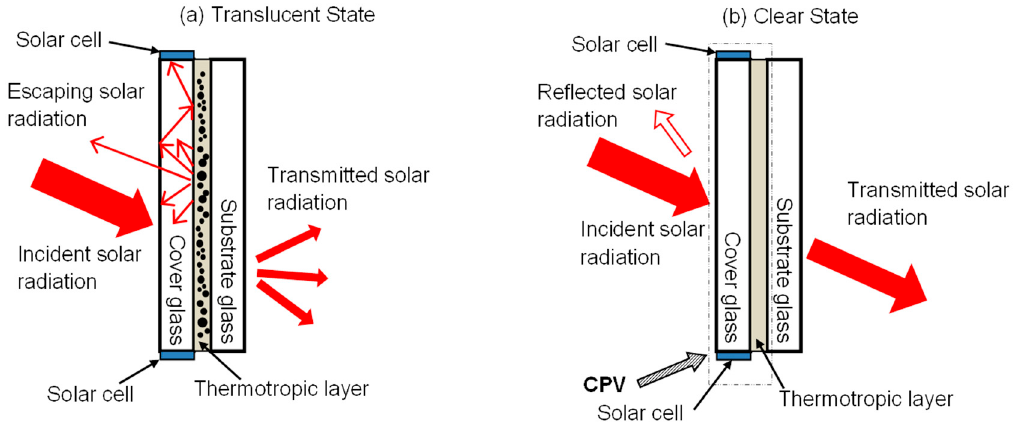
Figure 1. Schematic sketch of the proposed smart window, illustrating its working principle.